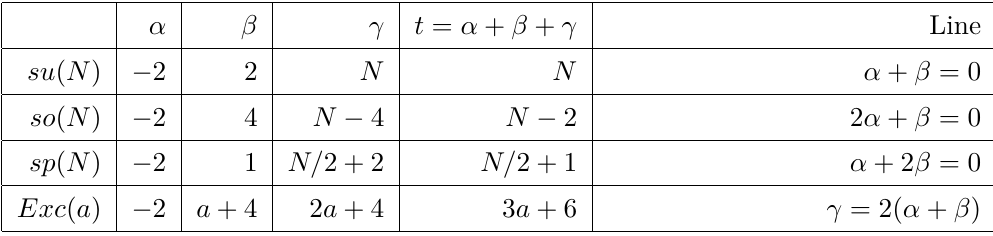
Table 1 . Vogel’s